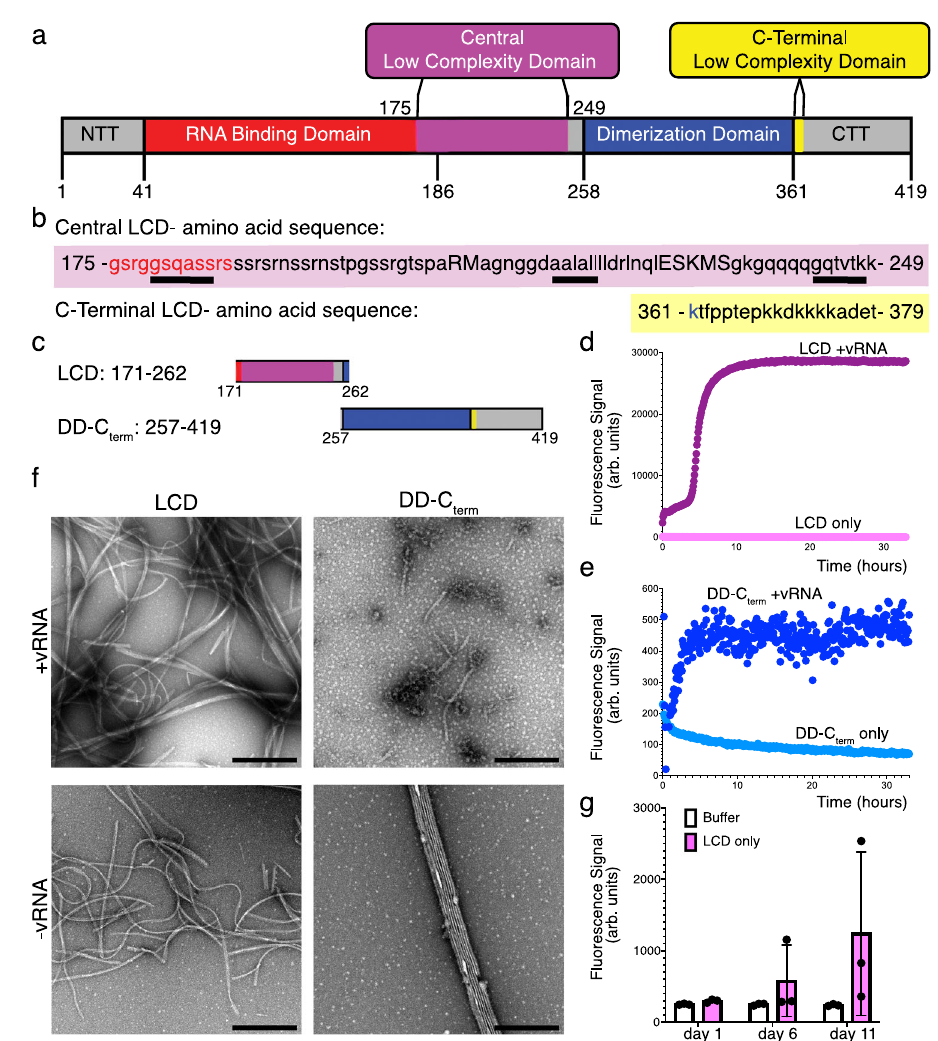
Fig. 1 | NCAP ’ s LCDs form fi brils and ThT-positive species. a NCAP ’ s domain organization.Domain de fi nitions: N-terminal tail (NTT, gray),RNA-binding domain (red); Central low complexity domain (LCD, purple; residues 175 – 249), Dimeriza- tiondomain(blue);C-terminaltail(CTT,gray).TheC-terminalLCDishighlightedin yellow (residues 361 – 379). b Amino acid sequence of the central and C-terminal LCDs highlighted and colored according to the color scheme in ( a ). Lowercase lettersrepresentresiduesoflowcomplexitywhilecapitallettersrepresentnon-low- complexity residues. No more than fi ve interrupting non-low-complexity residues betweenstrings of 10ormorelow-complexityresidues wereallowed.Steric-zipper forming sequences thatare discussed below are underlinedin the sequenceofthe central LCD. c Protein segments used in this study are abbreviated as LCD, con- sisting ofthe central LCD and surrounding residues, and as DD-C term , consisting of